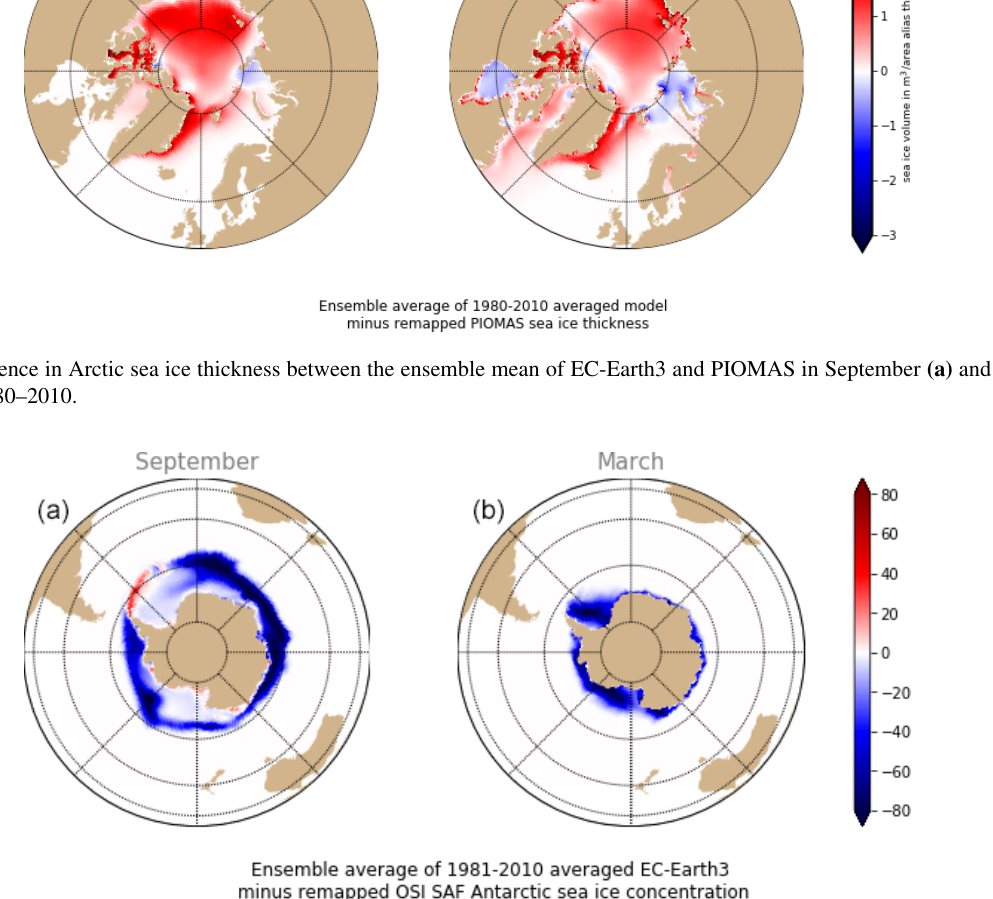
Figure 14. Difference in Antarctic sea ice concentration between the ensemble mean of EC-Earth3 and OSI SAF observations in September (a) and March (b) , averaged over